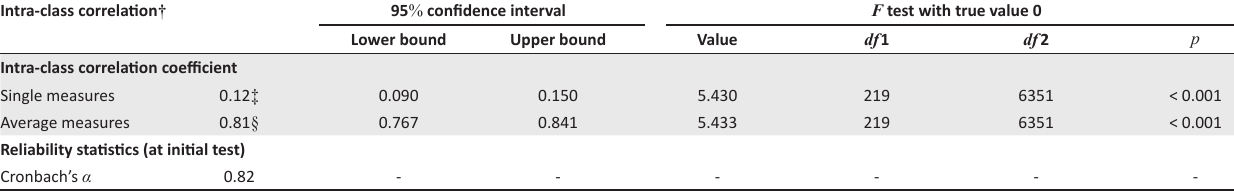
TABLE 3a: Cronbach’s alpha and intra-class correlation coefficient of personal evaluation of transitions in treatment. Intra-class correlation † 95 % confidence interval